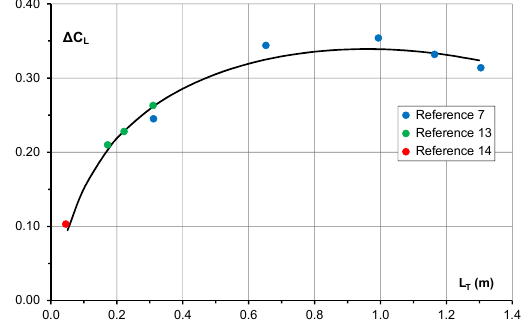
Figure A2. Lift increase as a function of slant length.